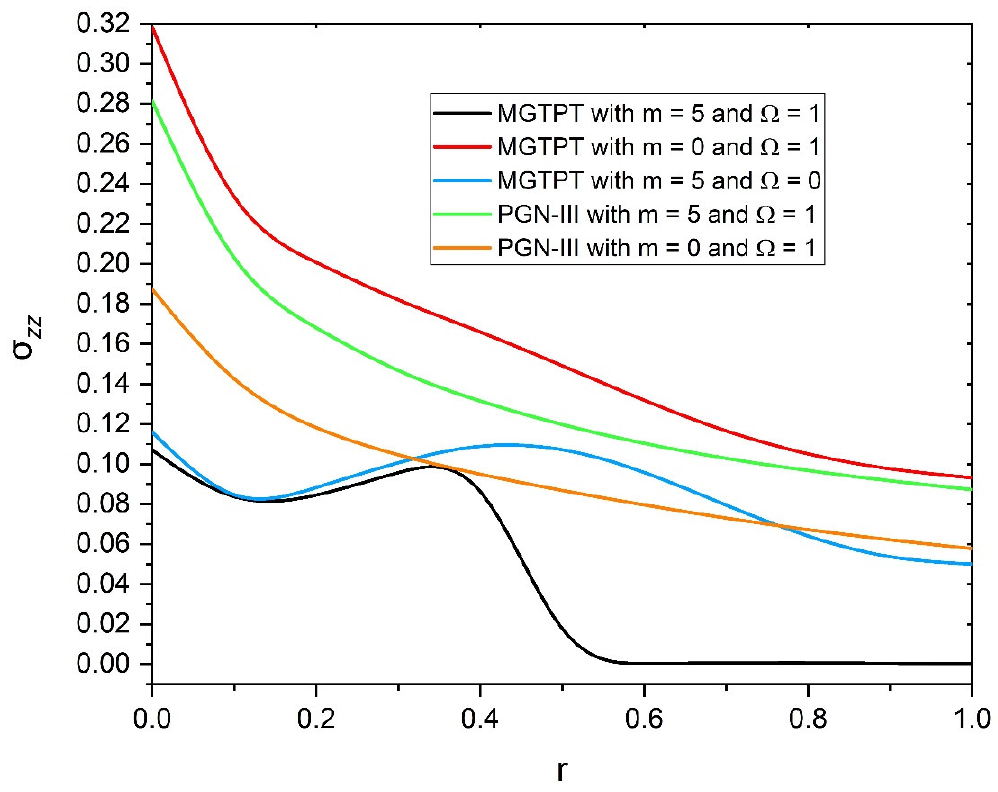
Figure 7. The deviation in vertical stress for various models with Hall effect and rotation.